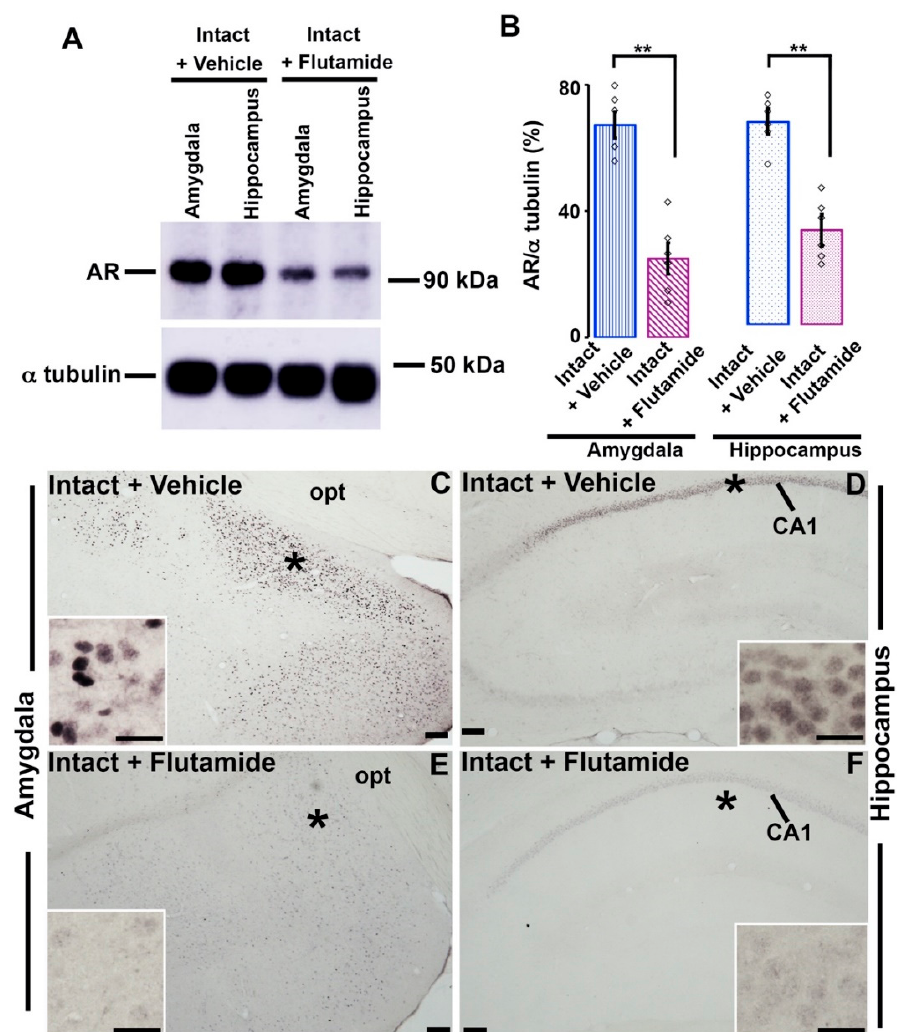
Figure 4. AR-expression in the amygdala or hippocampus in the intact and flutamide-injected male rats. ( A ) AR-immunoreactivity in the brain tissues containing the amygdaloid or hippocampal area were analyzed by Western blotting. ( B ) Total AR was normalized to α -tubulin. n = 6 for each group. Values are the mean ± SEM. ** p < 0.001. Photomicrographs showing AR-immunoreactivity in ( C , E ) amygdala and ( D , F ) CA1 hippocampus of vehicle and AR antagonist-treated intact rats. Insets are the enlargements of * in ( C – F ) respectively. Scale bar = 100 µ m in ( C – F ) and 20 µ m in insets. opt, optic tract. White rectangles in ( B ) represent data